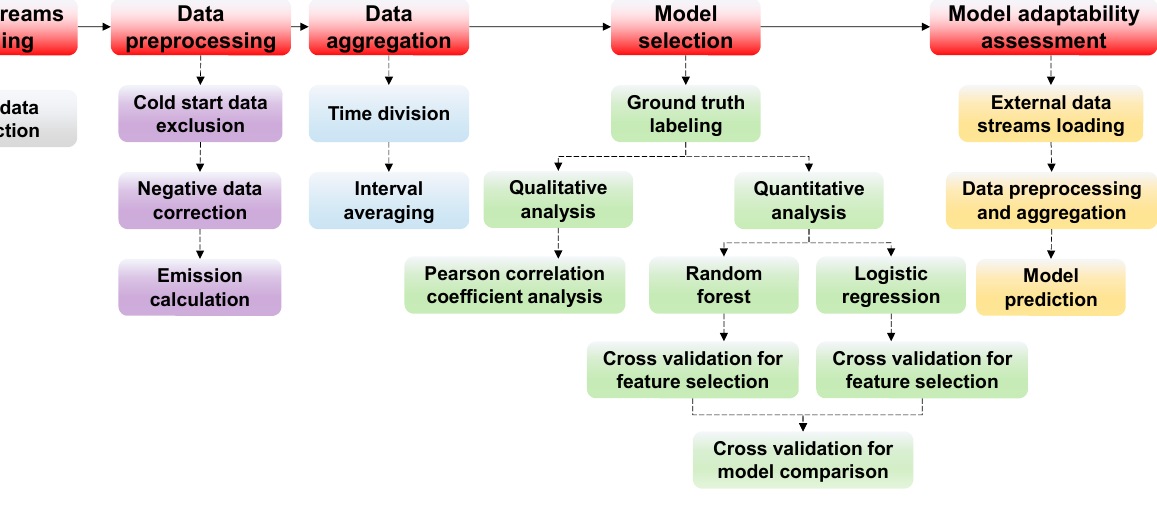
Figure 2. Investigation procedure.